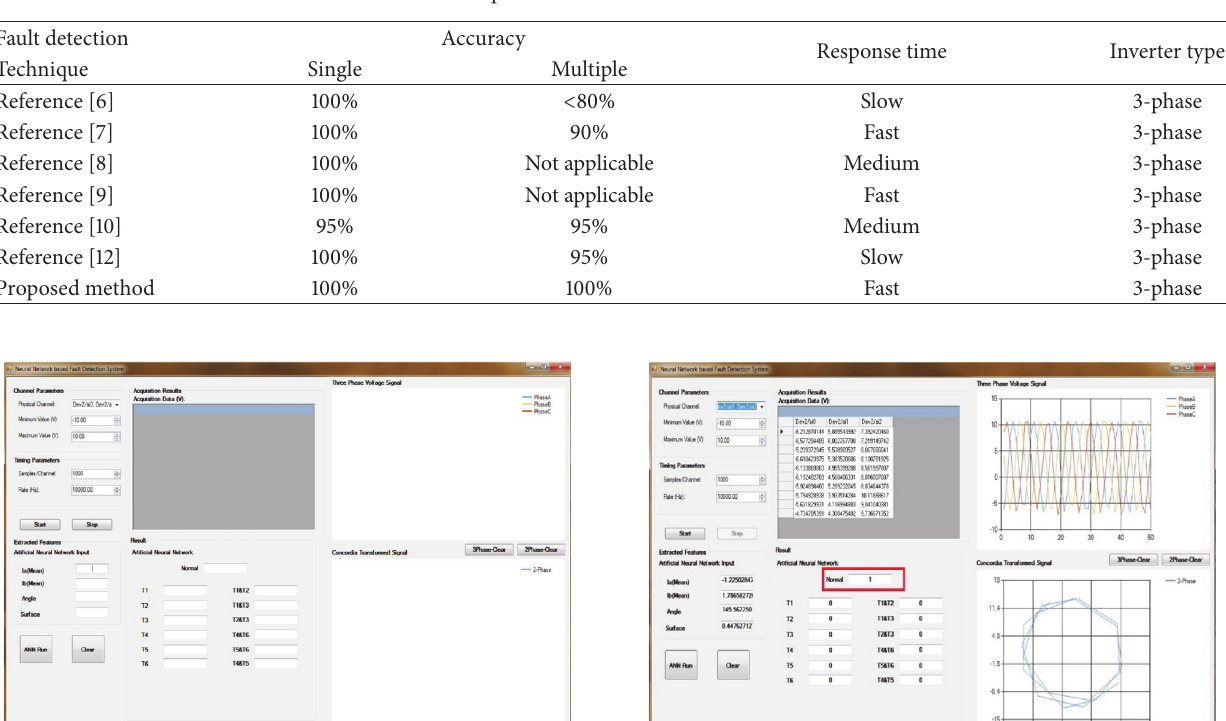
Table 2: Comparison table between different methods.